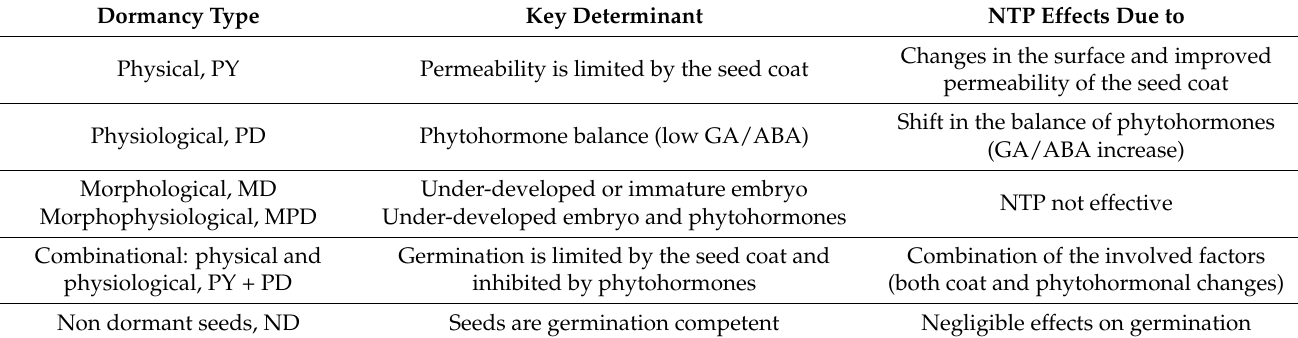
Table 2. Possible mechanisms of NTP effects on germination for seeds with different dormancy